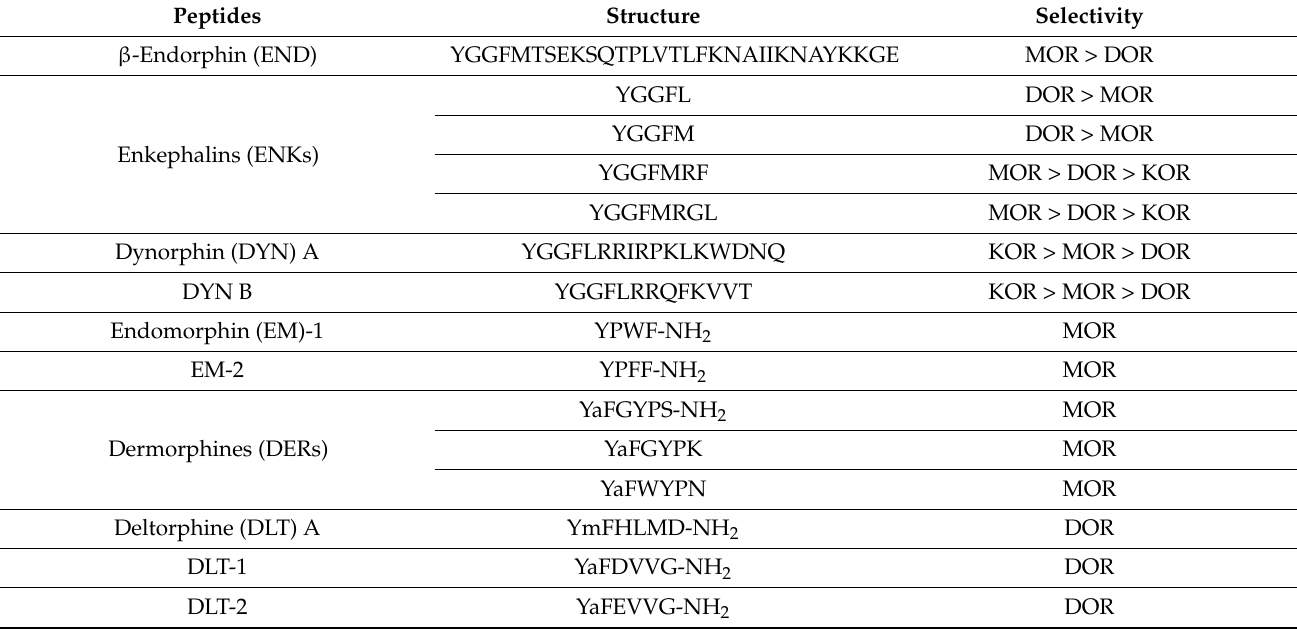
Table 1. Natural opioid peptides and their selectivities for the opioid receptors.